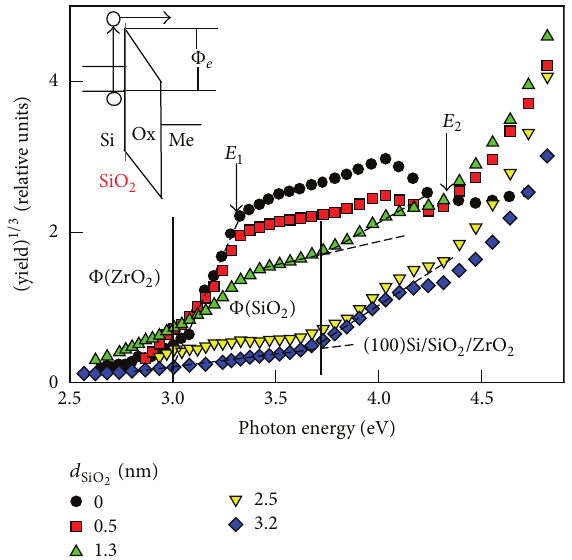
Figure 8: Cube root of the IPE yield as a function of photon energy for MOS capacitors with a 7.4 nm thick ZrO 2 insulator stacked with different SiO 2 ILs as illustrated in the inset. All curves are measured under an electric field of 2 MV/cm in the insulating layer closest to = 0 orSiO Si,thatis,ZrO 2 inthesamplewith 𝑑 2 inothersamples. SiO 2 The arrows 𝐸 1 and 𝐸 2 indicate onsets of direct optical transition in the silicon crystal. The spectral thresholds of electron IPE from the VB of Si into different oxides are indicated by vertical